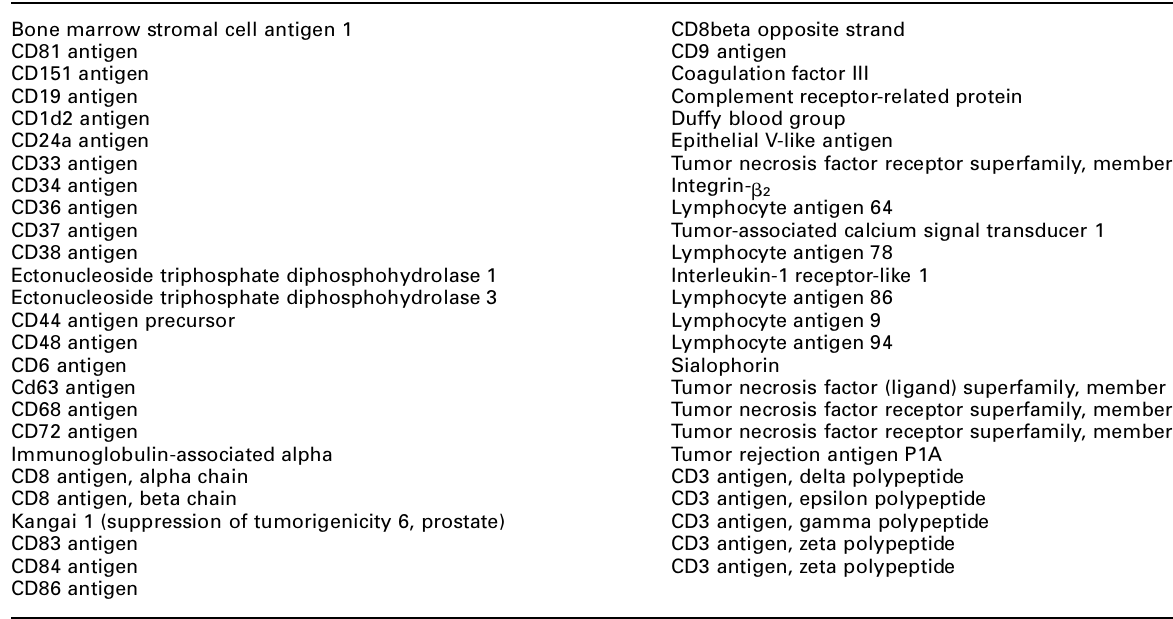
Table 1. The cDNAs for cell surface antigens tested in the present study Bone marrow stromal cell antigen